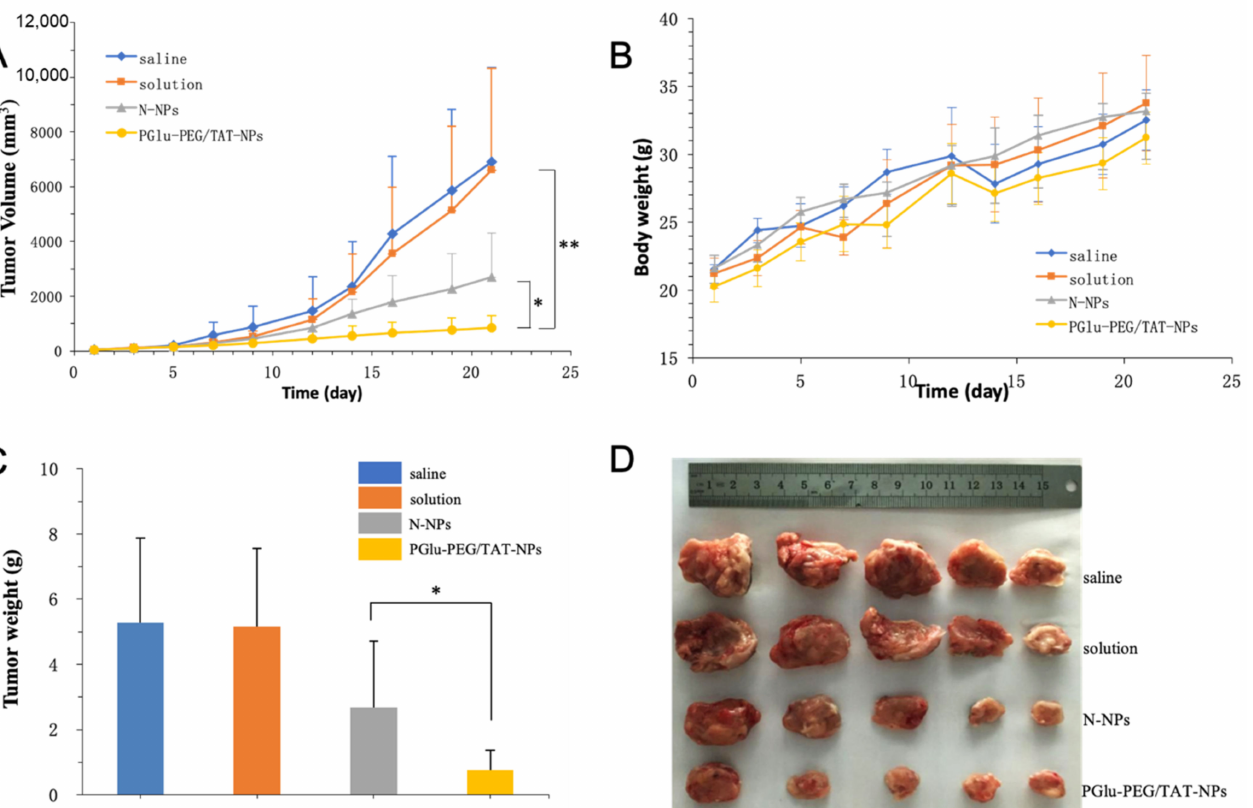
Figure 7. In vivo antitumor study of PGlu-PEG/TAT-NPs in H22 xenograft tumor. ( A ) Tumor growth curves following the treatment with saline, solution, N-NPs, and PGlu-PEG/TAT-NPs. ( B ) Mice body weight variations during treatment. ( C ) Weight of dissected tumors after treatment ( n = 5). * p < 0.05; ** p < 0.01. ( D ) Picture of tumors after treatment. Solution: DSF dissolved in saline with a low content of Cremophor EL/ethanol. N-NPs: DSF-loaded naked nanoparticles. PGlu-PEG/TAT-NPs: shell/core composite